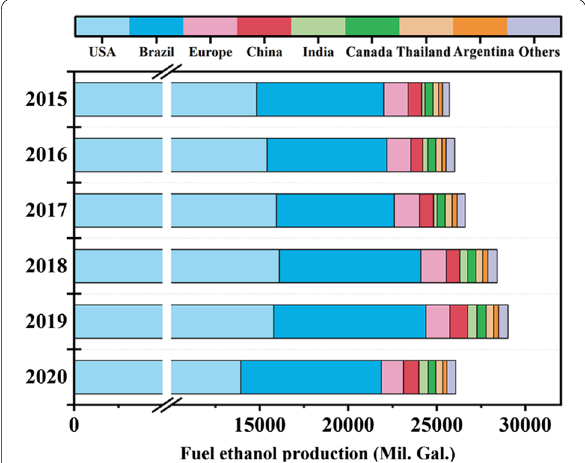
Fig. 1 Annual world fuel ethanol production from 2015 to 2020